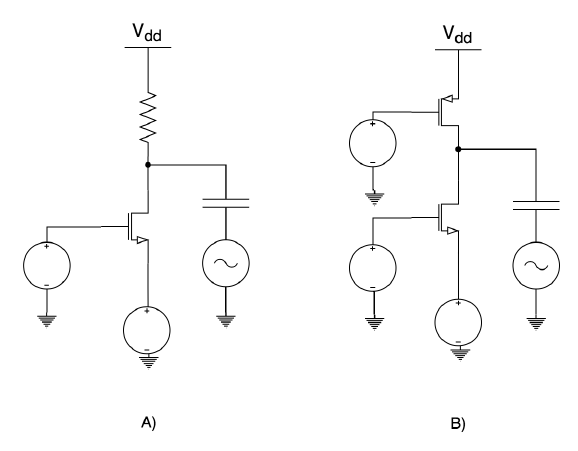
Figure 13. Schematics of the common gate stage, with passive ( A ) and active ( B ) load